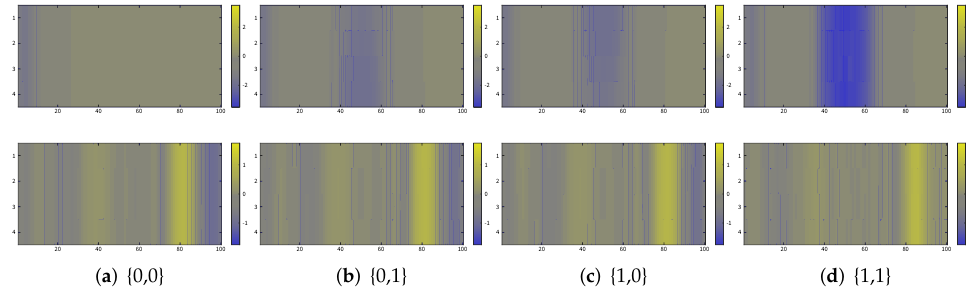
Figure 12. Example of the NAND gate topology for { x , y } = {1,1}. Voltage ( V ) across capacitors C of each M - RLC circuit ( top ) and the respective memristances ( Ω ) ( bottom ) on 3 different time frames.